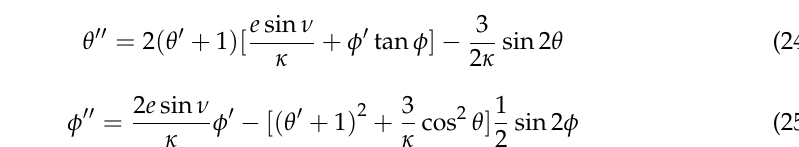
Figure 2. ( a ) Tether in-plane angle, θ , versus ν ; ( b ) angular velocity of the in-plane angle, θ (cid:48) , versus θ .